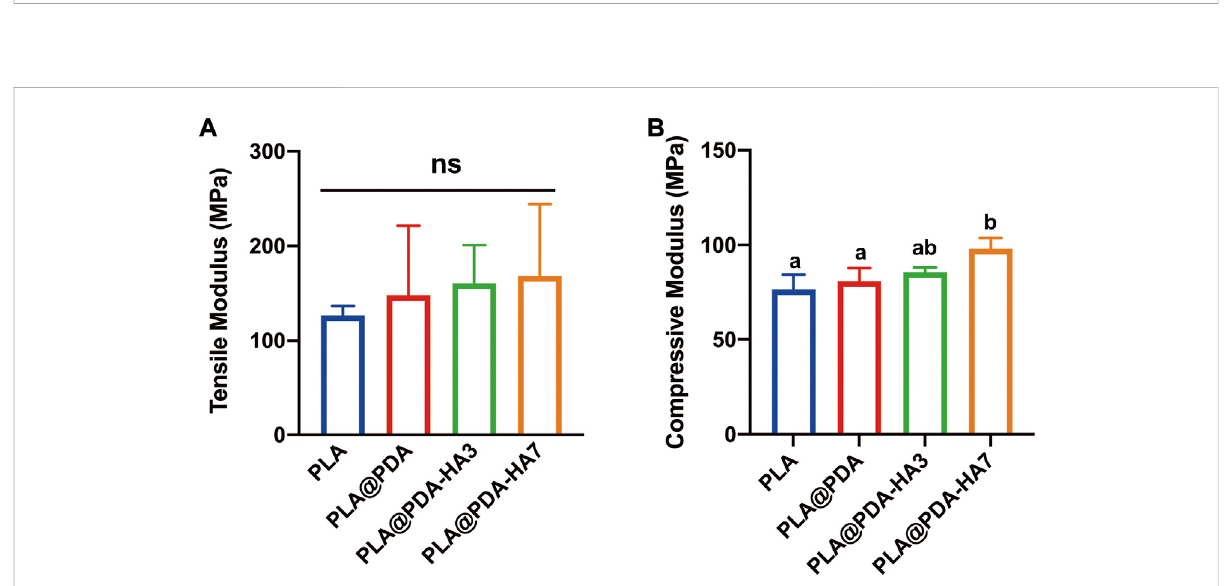
FIGURE 6 Mechanical properties of PLA, PLA@PDA, PLA@PDA-HA3, and PLA@PDA-HA7 scaffolds. (A) Tensile modulus and (B) compressive modulus of each specimen. Dissimilar letters indicate statistical differences between groups ( n = 3, p <